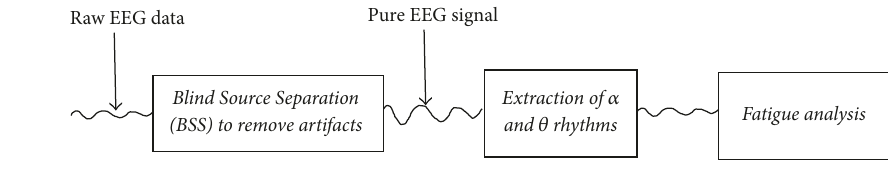
Figure 2: Three steps for signal processing and fatigue analysis.